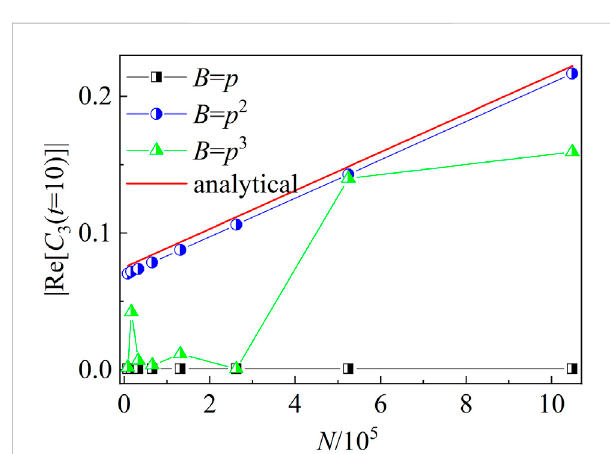
FIGURE 8 |Re [ C 3 ( t )]| at the time t = t 10 versus N with B = p (squares), p 2 (circles), and p 3 (triangles). Red solid line indicates our theoretical prediction in Eq. 15 with η = 6.05 × 10 − 7 for B = p 2 . The parameters are the same as in Figure